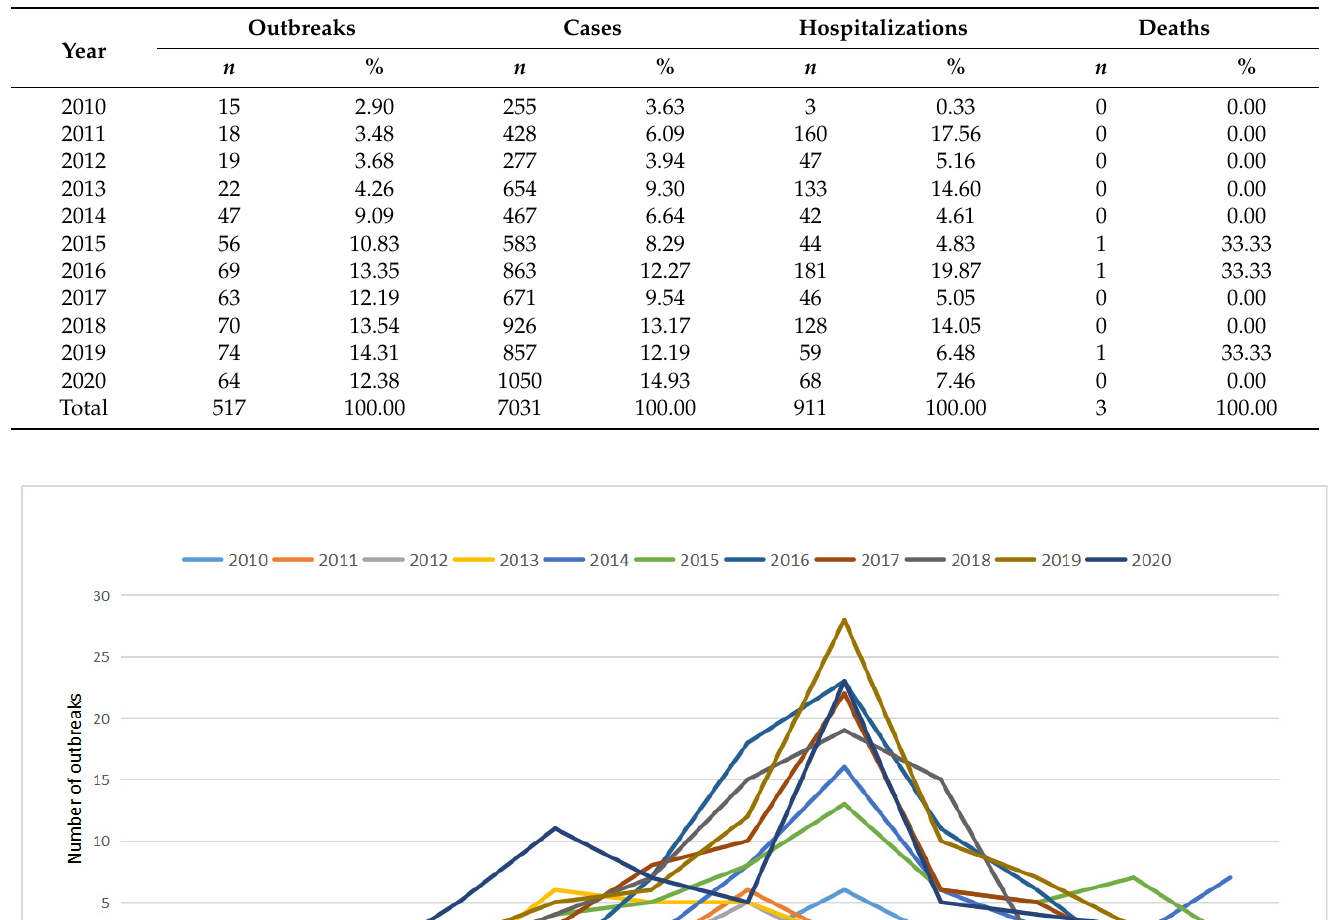
Table 1. Annual distribution of outbreaks of bacterial FBDOs in Zhejiang Province, 2010–2020.